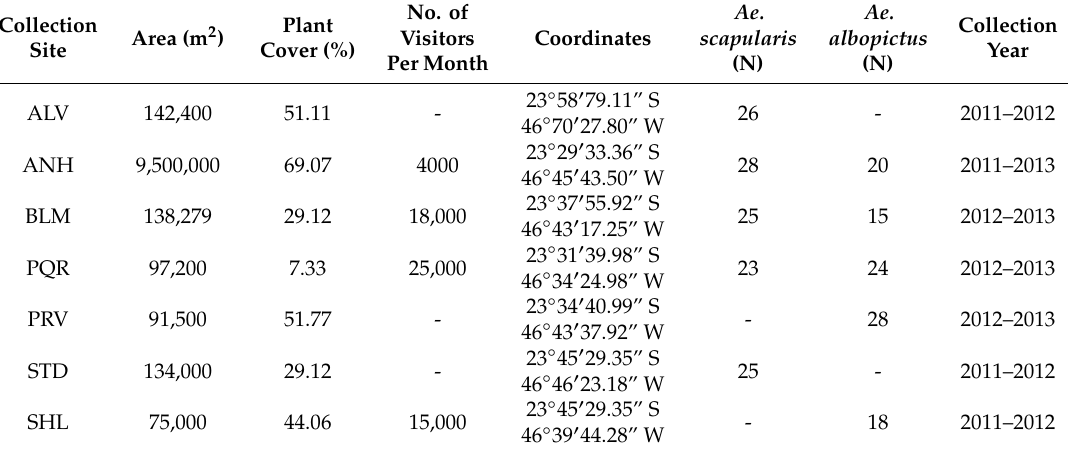
Figure 1. Locations where Ae. albopictus and Ae. scapularis sampling was performed in São Paulo, Brazil: Alfredo Volpi Park (ALV); Anhanguera Park (ANH); Burle Marx Park (BLM); Piqueri Park (PQR); Previdencia Park (PRV); Shangrilá Park (SHL); and Santo Dias Park (STD). Table 1. Aedes scapularis and Ae. albopictus collection sites and data (- = no data).